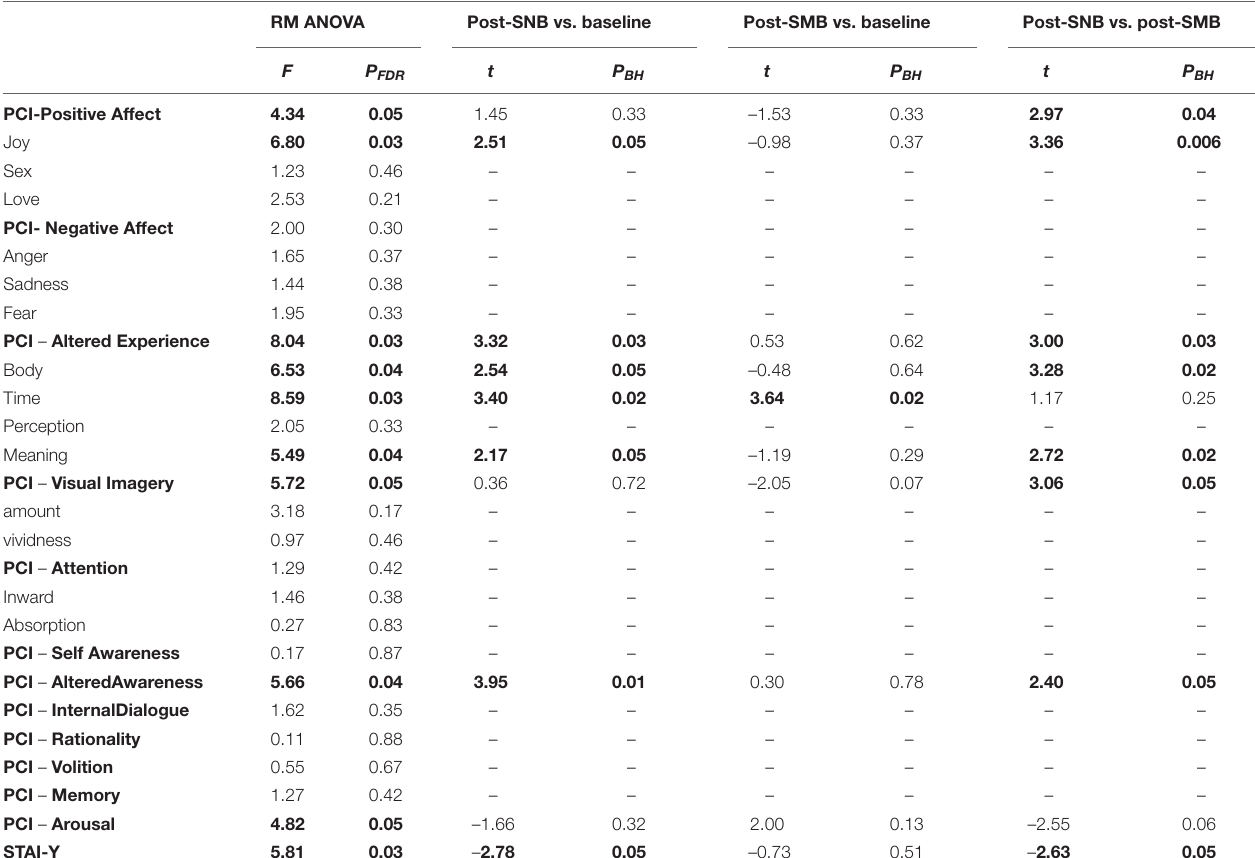
TABLE 1 | Repeated measures ANOVA statistics for PCI scales and sub-scales and STAI-Y scores are reported (phase: baseline, post-SNB, post-SMB, as a three-level within factor). RM ANOVA Post-SNB vs. baseline Post-SMB vs.